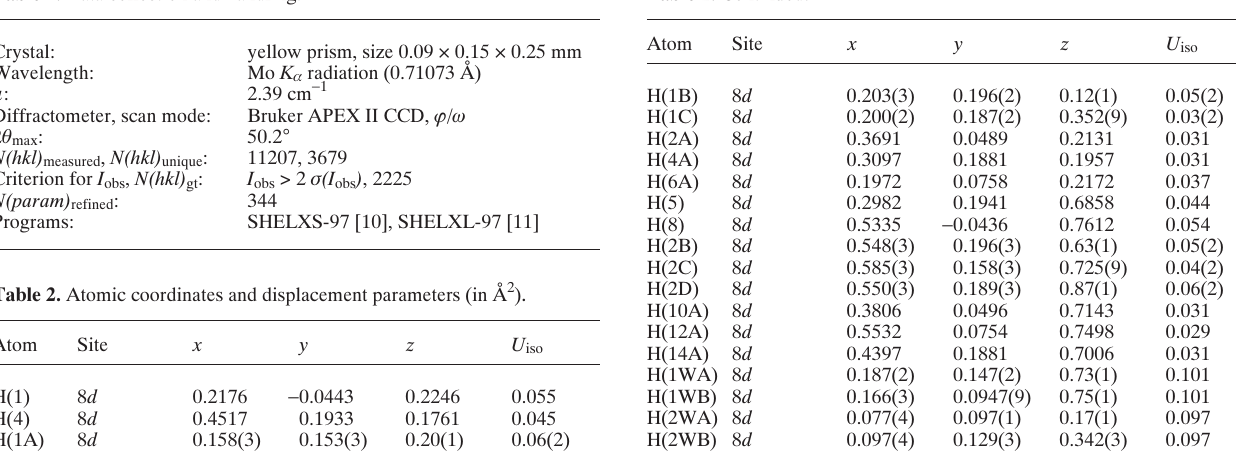
Table 1. Data collection and